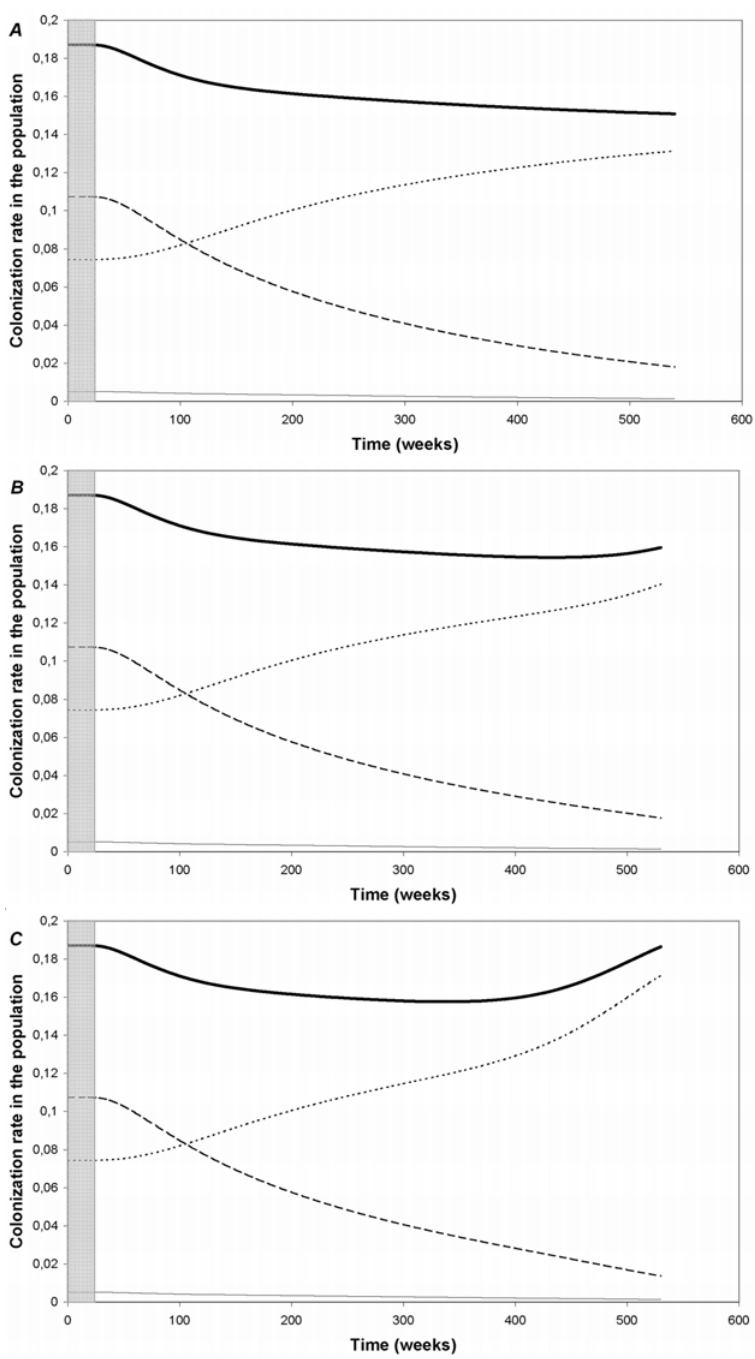
Figure 2. Time changes in the pneumococcal population in the post-vaccine era: global colonization rate (bold line), colonization with vaccine serotypes (dashed line), non-vaccine serotypes (dotted lines), and dual colonization with vaccine and non-vaccine serotypes (full line), a) with a frequency of vaccine-selected capsular switch r =0, b) with a frequency of vaccine-selected capsular switch r =10 2 4 /week, and c) with a frequency of vaccine-selected capsular switch r =10 2 3 /week.